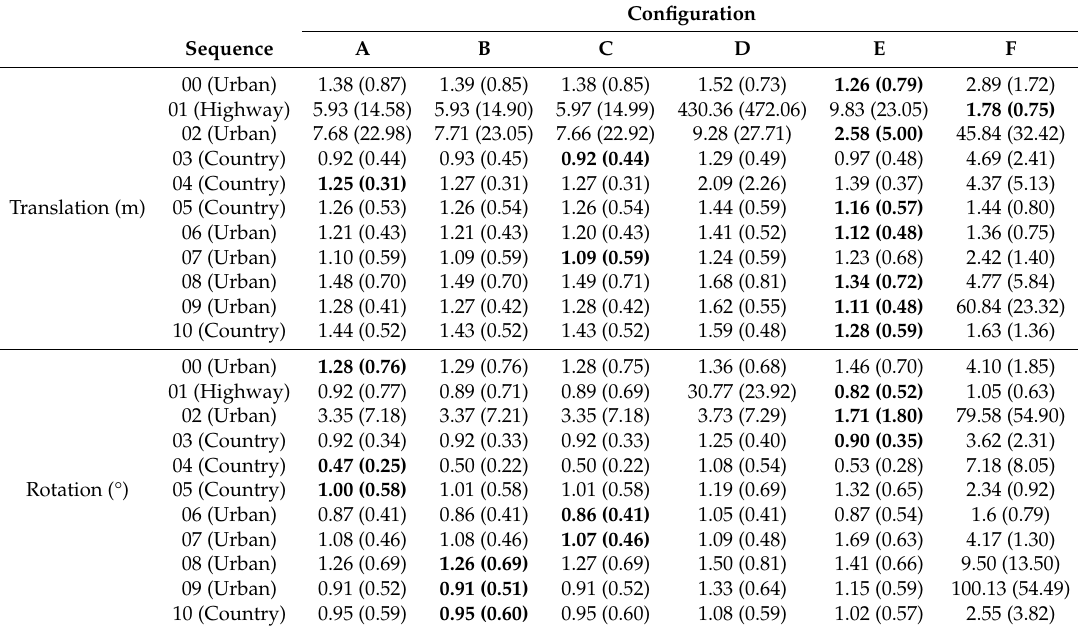
Table 2. Relative Pose Error (RPE) on the different KITTI odometry sequences for each configuration.